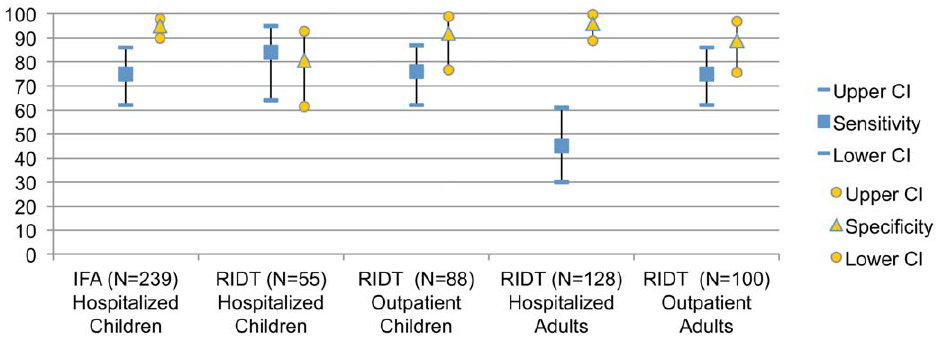
Figure 1. Sensitivity of IFA tests and RIDTs for the detection of pandemic H1N1 influenza. Sensitivity was calculated using real-time reverse transcriptase polymerase chain reaction as the gold standard. IFA results for other groups were not available due to lack of data.